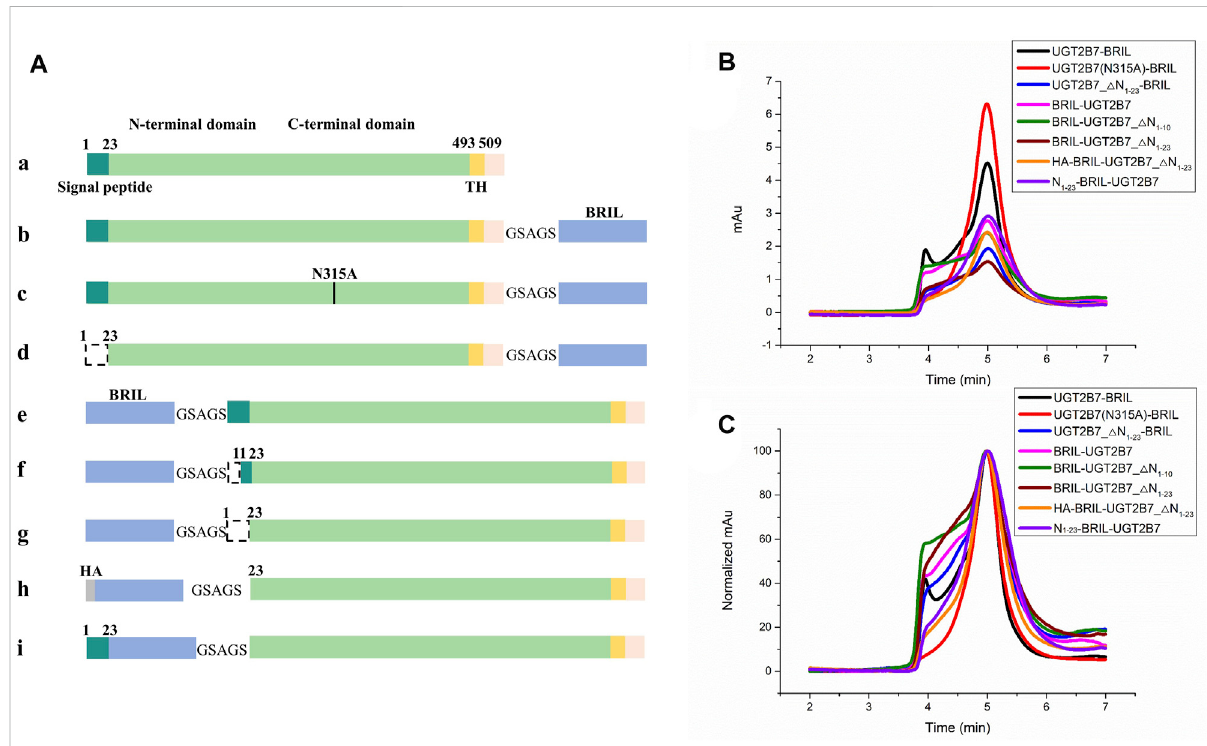
FIGURE 2 Screening for insertion sitesof the fusion protein BRIL to UGT2B7. (A) Color-codeddomain architectureof different insertion sites. The dashed line represents the truncation. HA, hemagglutinin signal peptide. (B) Size exclusion chromatography curves of different constructs at a fl ow rate of 0.5 ml/min. The X -axis represents the time and Y -axis shows the UV absorption at 280 nm representing the yields of protein. Fused BRIL at the C-terminus increased the yields of the full-length UGT2B7 (blank curve). Fused BRIL at the N-terminus, regardless of the signal peptide length, the proteins were not properly expressed and the aggregation was signi fi cantly high (magenta, olive, and wine curves). The addition of the haemagglutinin (HA) signal peptide or the supplementation of the UGT2B7 signal peptide (residues N1-23) before BRIL (orange and purple curves) showed better homogeneity and higher yields. (C) The alignment of all curves in B shows the protein